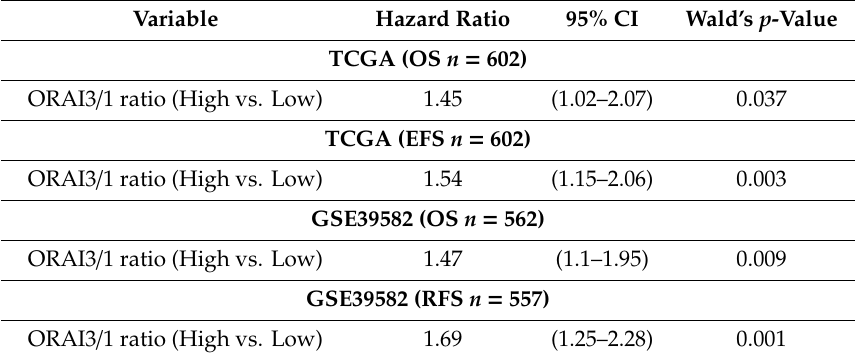
Table 2. Univariate analysis of ORAI3 / ORAI1 ratio with survival in TCGA and GSE39582.